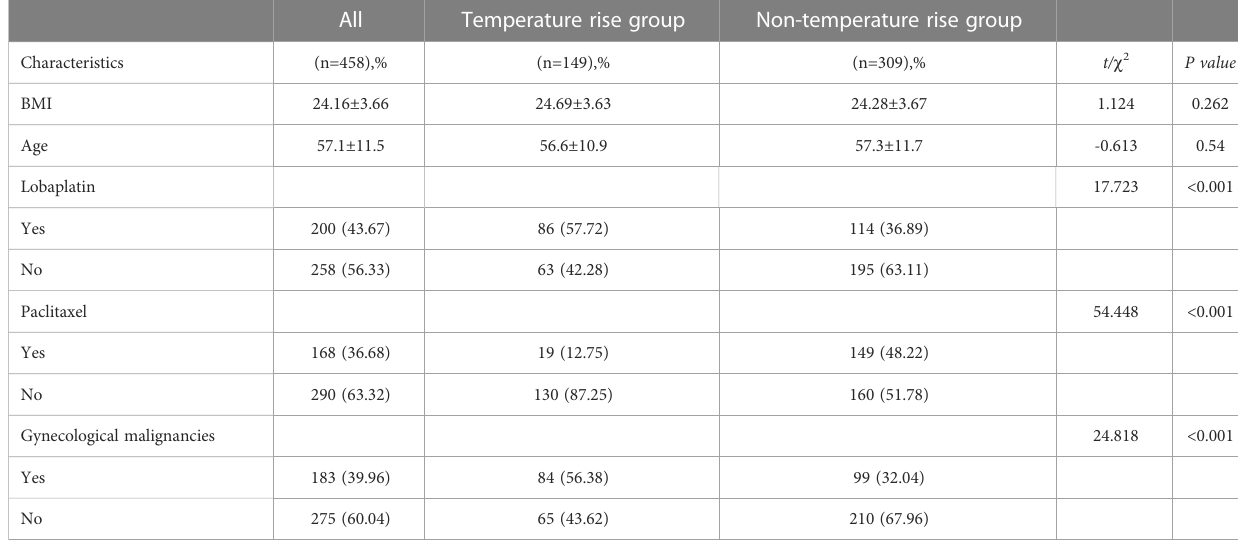
TABLE 2 Data of patient classi fi cation.